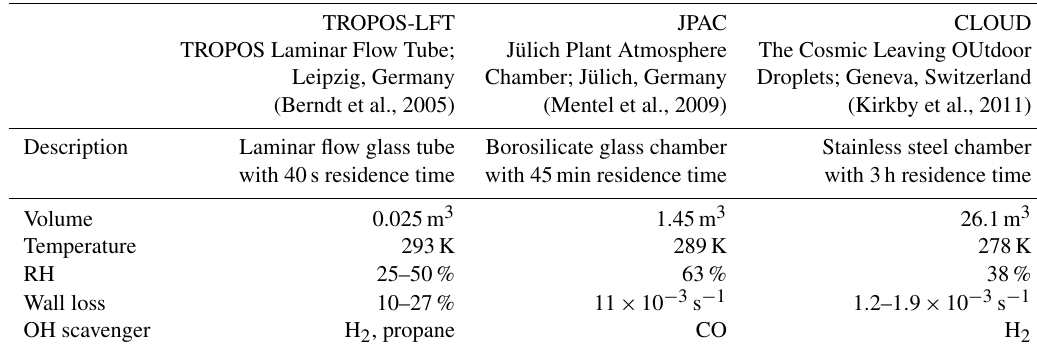
Table 1. Description of different experimental systems compared in this